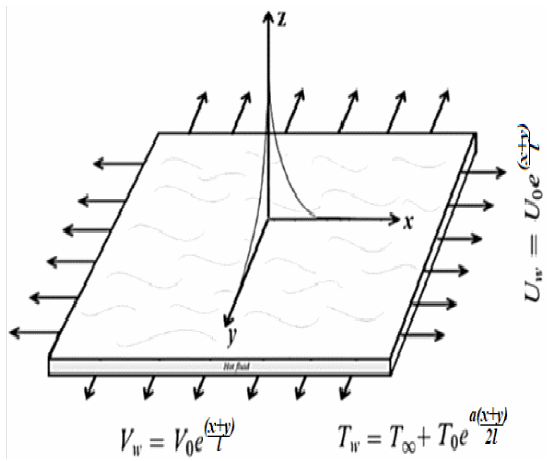
Figure 1. Flow pattern of micropolar hybrid